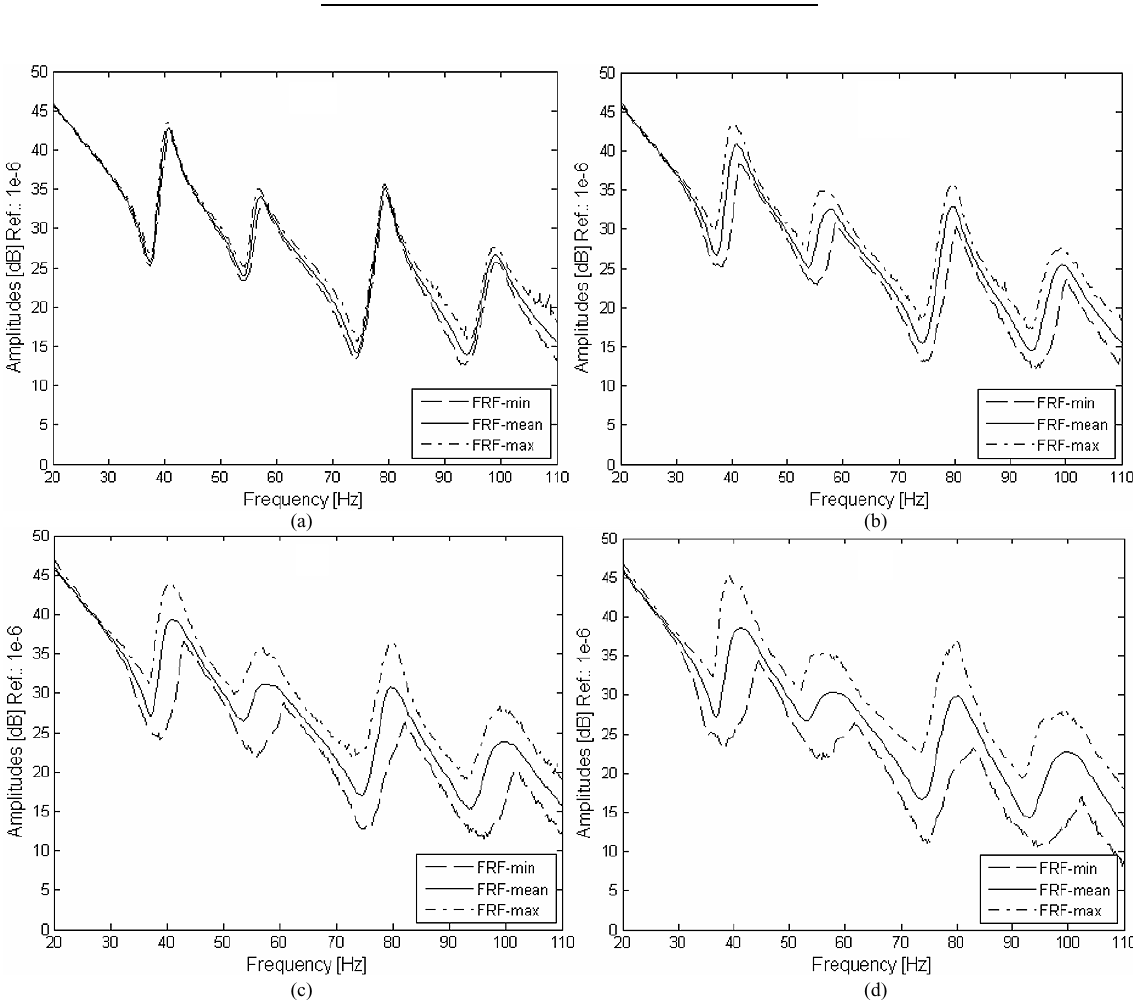
Fig. 6. Envelopes of random FRFs of the plate treated with constrained layers for uncertainty levels: (a) Case 1; (b) Case 2; (c) Case 3; (d) Case 4. eigenvectors, one residual vector associated to the external force, 54 residual vectors associated to the damping forces). Figures 7(b), 7(c) and 7(d) show the amplitudes of the FRFs computed by using the three bases, as